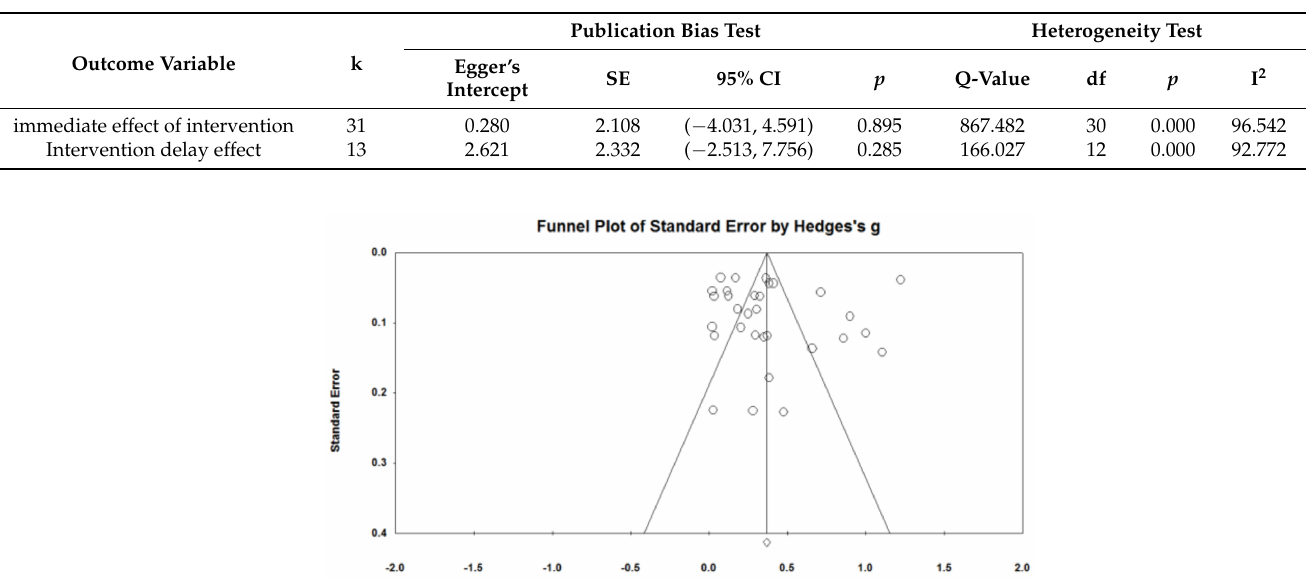
Table 2. Heterogeneity test and publication bias Egger’s linear regression.